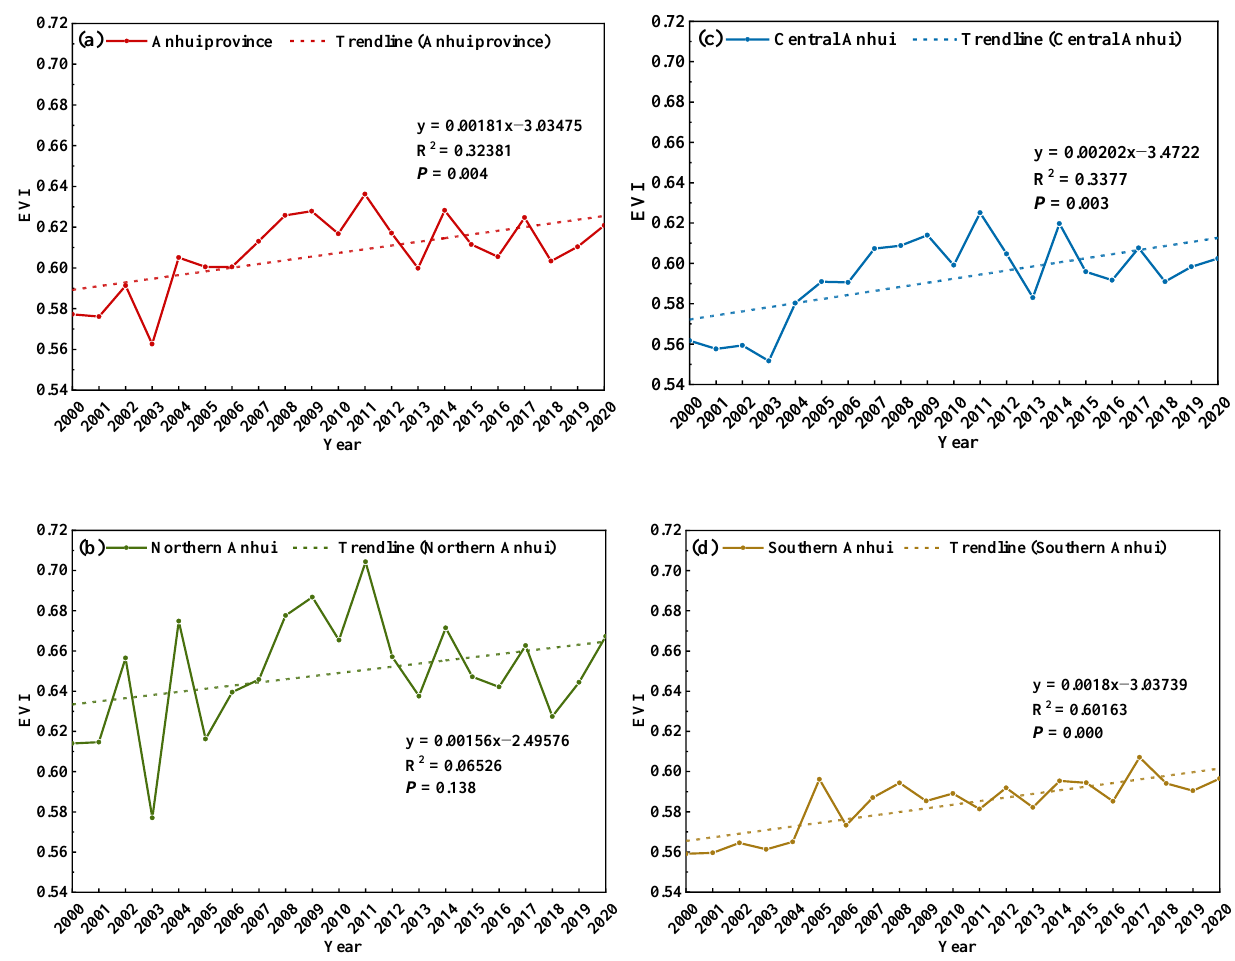
Figure 3. Temporal variations in annual maximum EVI mean during 2000–2020 in Anhui Province. ( a ) The entire Anhui Province and ( b ) Northern, ( c ) Central and ( d ) Southern Anhui.